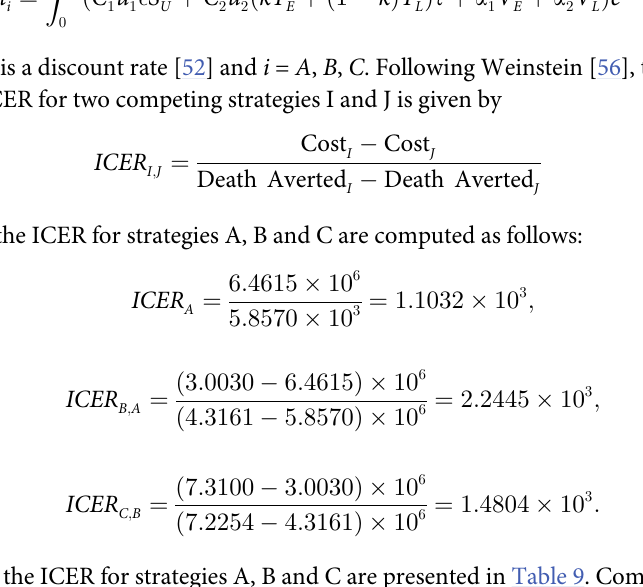
Strategy Death averted Cost of strategy($) ICER/($) Strategy A 5,857 6,461,500 1,103.2 Strategy B 4,316.1 3,003,000 2,244.5 Strategy C 7,225.4 7,310,000 1,480.4